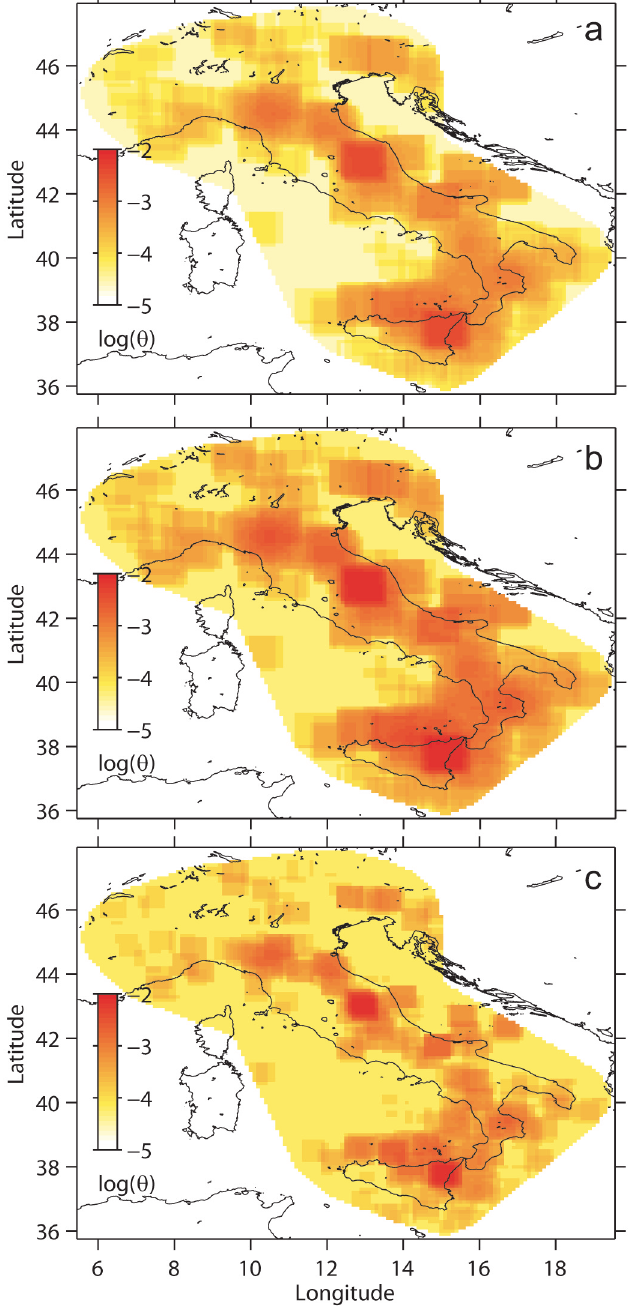
Figure 6. RI-based prospective forecast maps. (a, b) Forecast maps for the 5-year period from t = August 1, 2009, to t = August 1, 2014 (a) and the 2 3 10-year period from t = August 1, 2009, to t = August 1, 2019 (b), for 2 3 ) is 5 ≤ M ≤ 9 events. The logarithm of the cumulative forecast number ( i i given in the color code. The tables of the numerical data used for these maps have been submitted to the testing center. (c) Forecast map for the period from t = January 1, 1985, to t = March 31, 2009, for the 3-month forecast 0 1 for 4 ≤ M ≤ 9 earthquakes. An executable computer code that can compute used for (c) has been submitted to the testing the forecast numbers m iM